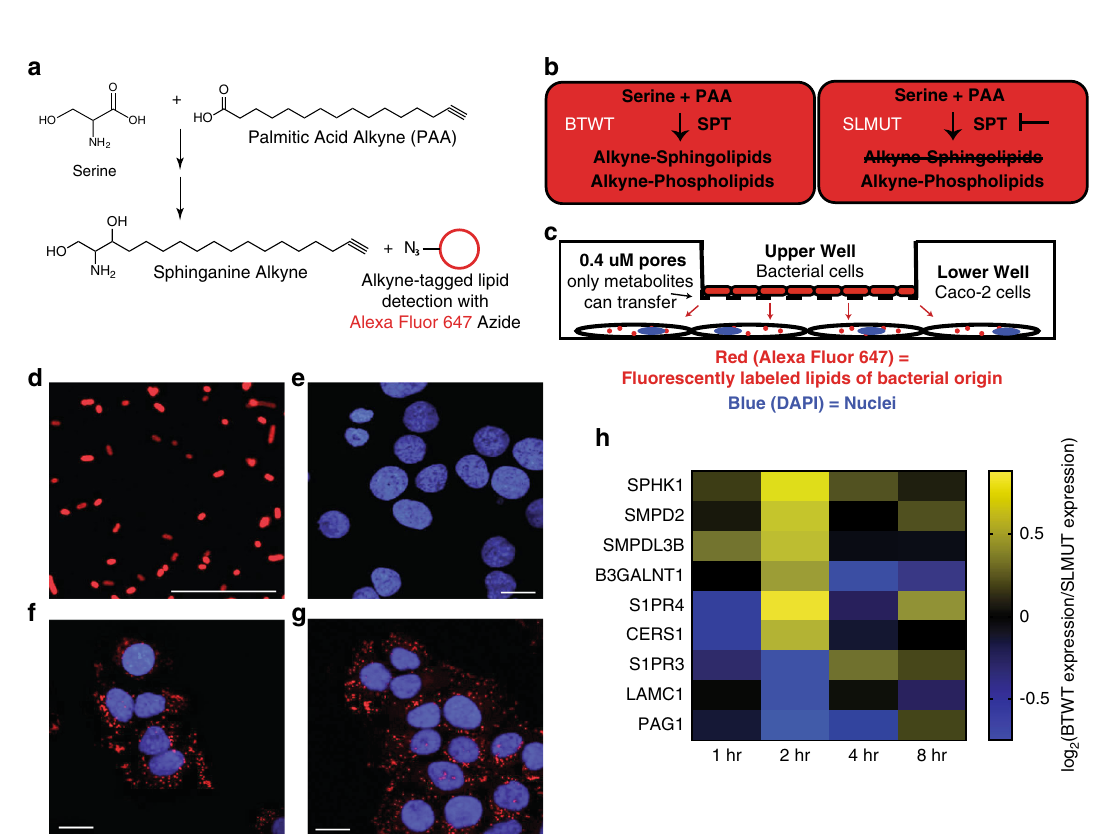
Fig. 2 SL production by BTWT regulates SL metabolism genes. a Incorporation of palmitic acid alkyne (PAA) into complex SLs allows fl uorescent detection of bacterially-derived lipids using an azide (N 3 ) conjugated fl uorophore (Alexa Fluor 647). b Metabolism of PAA in BTWT vs. SLMUT. SPT = serine palmitoyltransferase. c Illustration of the transwell coculture system, showing transfer of PAA derivatives from bacterial cells in upper well to Caco-2 cells in lower well. d Confocal image showing alkyne-tagged lipids detected in BTWT cells grown with PAA (red - Alexa Fluor 647; detection by click chemistry). Scale bar is 20 μ m. Confocal microscopy image of Caco-2 cells in the lower transwell after 6-h exposure to ( e ) cell culture media ( f ) BTWT- PAA or ( G ) SLMUT-PAA. e – g Alkyne-tagged lipids were detected by Alexa Fluor 647 (red) and DNA was stained using DAPI (blue). Images are representative of three independent experiments. Scale bar is 20 μ m. f Heatmap showing the average time-zero normalized log 2 change in gene expression between BTWT and SLMUT in transwell with Caco-2 cells for two biological replicate 8-h time course experiments (yellow = higher, blue = lower for log 2 BTWT/SLMUT relative expression). Source data are provided as a source data fi